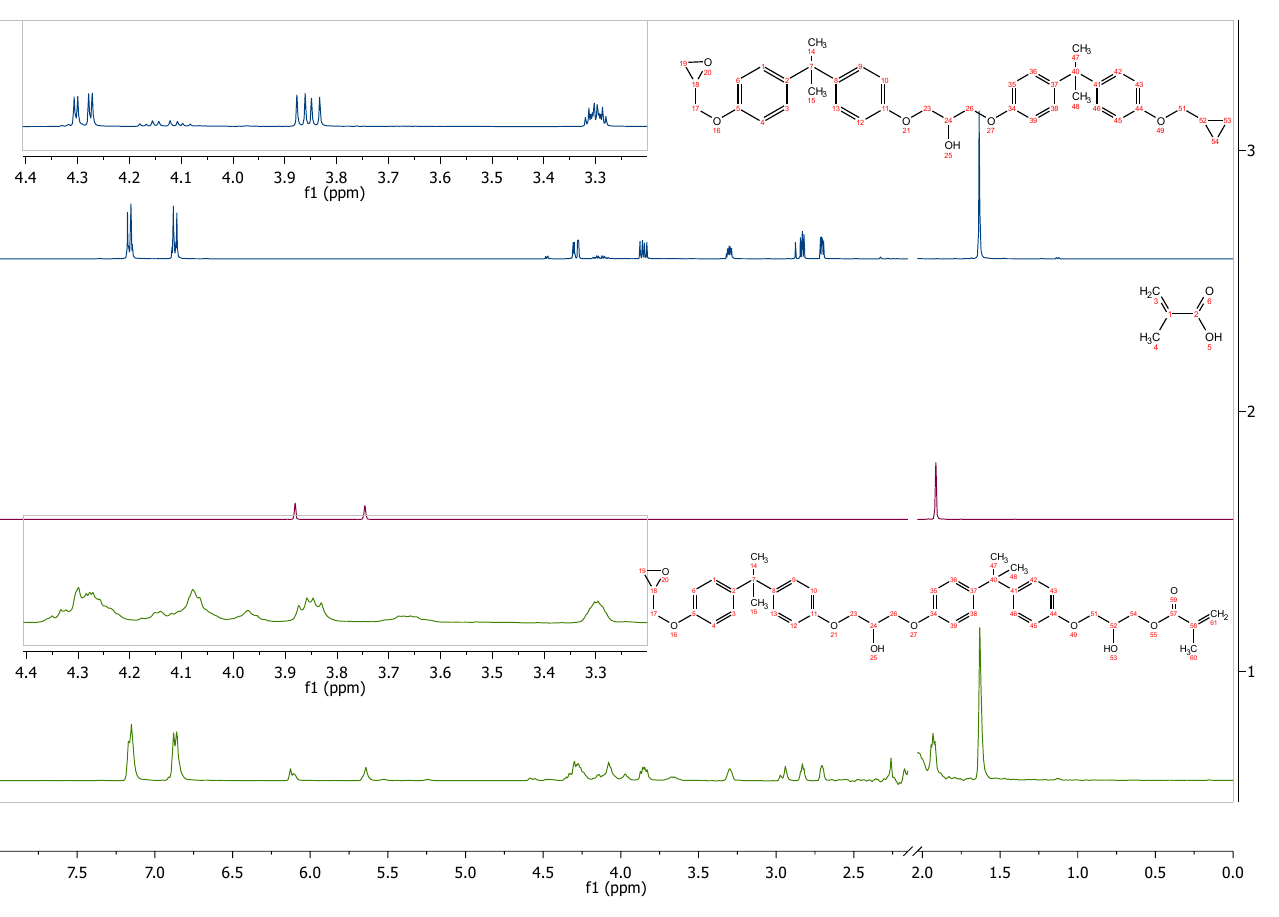
Figure 3. 1 H NMR spectrum (d-acetone) of epoxy resin, methacrylic acid, and EA